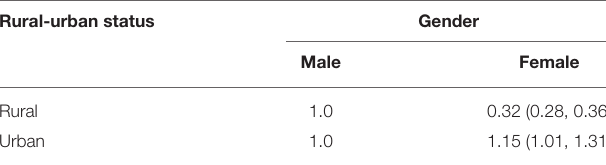
TABLE 3 | Adjusted association between rural-urban status and FOBT use.